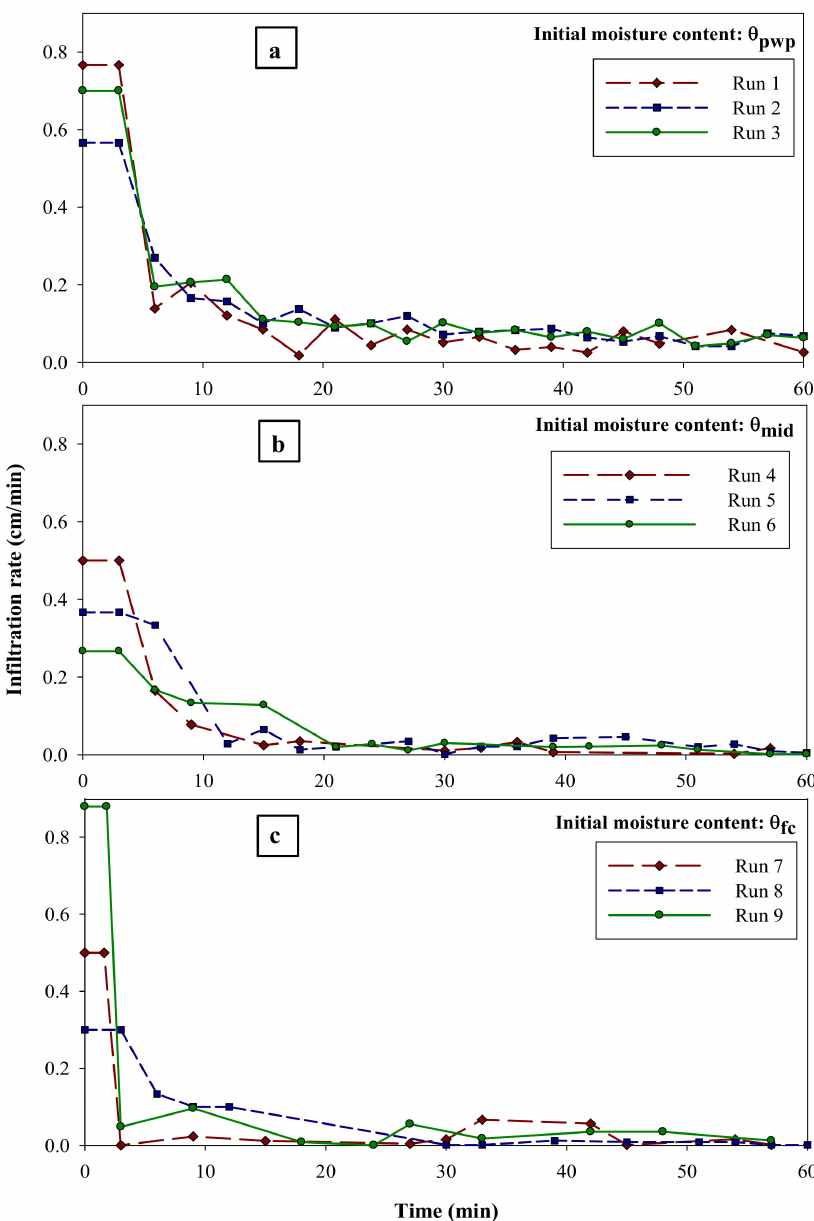
Figure 8. Infiltration rate vs. time over 60 min duration of experiments for: ( a ) Runs 1, 2, and 3 with initial water content of permanent wilting point ( θ pwp ); ( b ) Runs 4, 5, and 6 with initial water content between θ pwp and field capacity ( θ fc ); and ( c ) Runs 7, 8, and 9 with initial water content θ fc